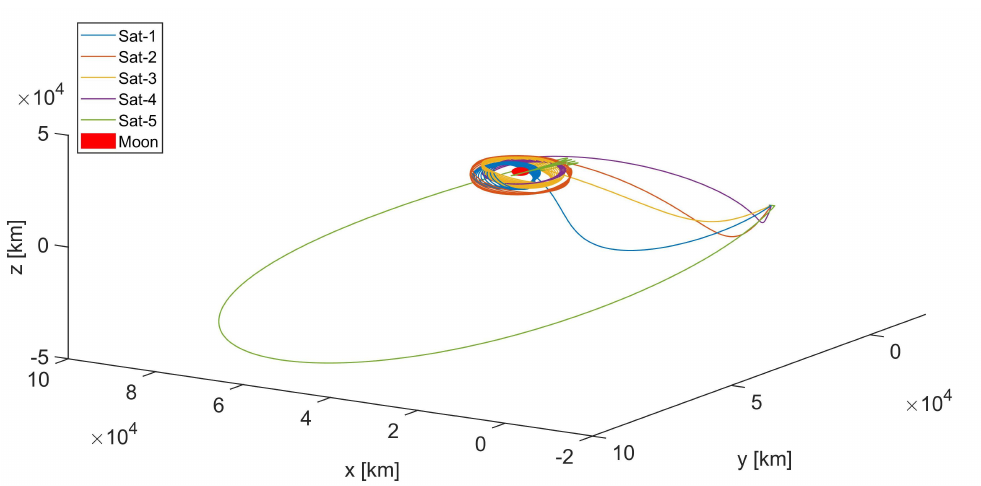
Figure 3. Satellites trajectories during Phase 2: 3D view in the rotating